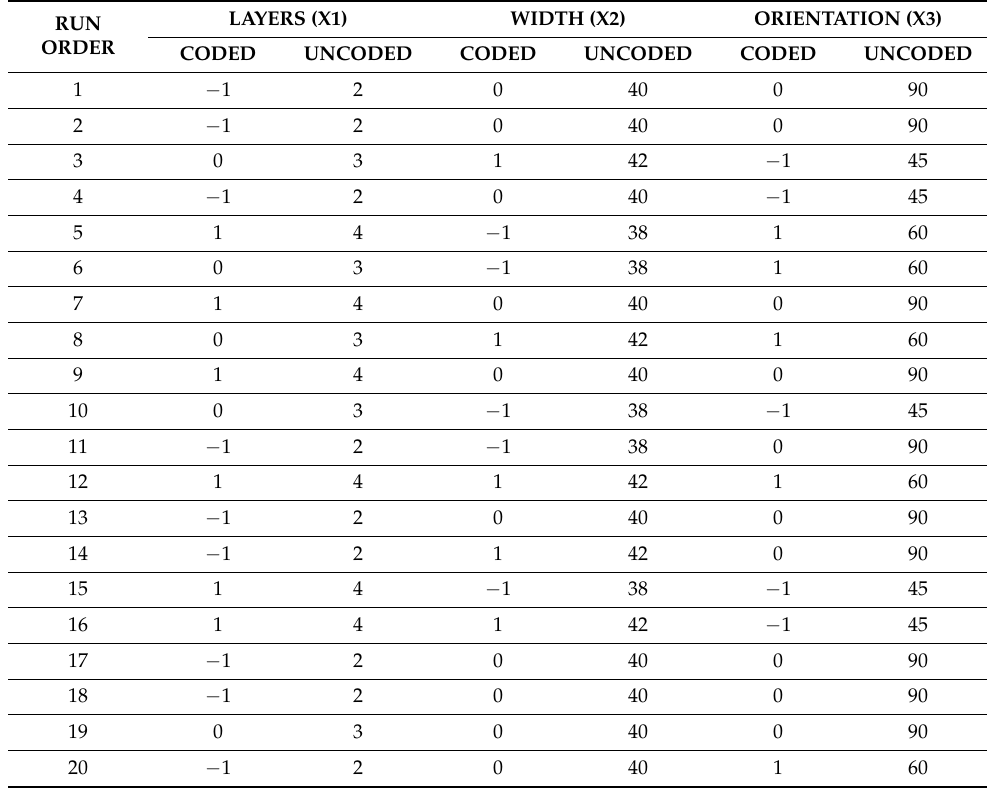
Table 2. Response surface